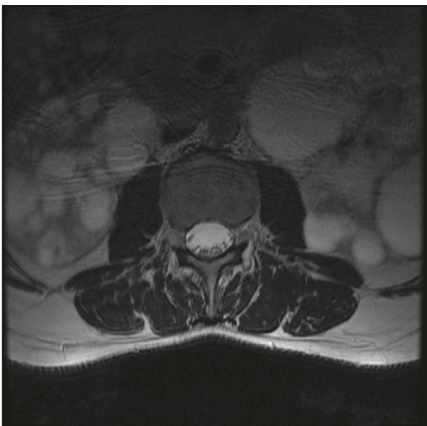
Figure 3: T2-weighted axial MRI scan indicating enlarged kidneys and multiple Hgb 14.1 g/dL, PLT 210,000/ µ L, serum urea 41 mg/dL, sCR